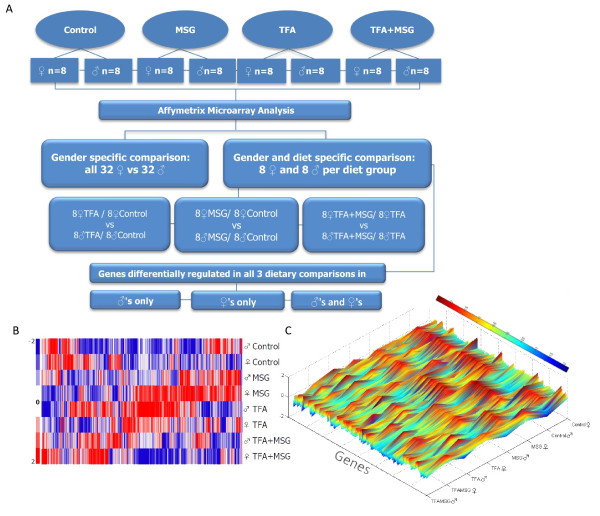
Diet effects on cardiac gene expression. A: Experimental design and statistical model. Eight samples per diet group were hybridized onto Affymetrix 1.0ST GeneChip arrays. B: 2D heatmap of 6791 sex-specific cardiac genes (P < 0.01). C: 3D heatmap of standardized expression values of DEGs with an FDR adjusted ANOVA p-value of <.01 for sex and diet.